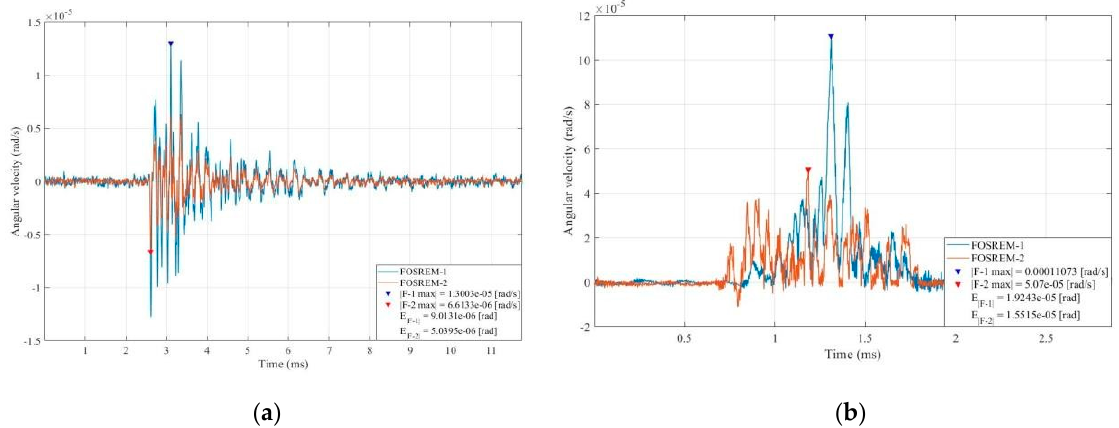
Figure 3. Data recorded by the FOSREMs in the geophysical observatory in Ksi ąż , Poland: ( a ) torsion event on the 1 December 2017, at 12:19 UTC, ( b ) tilt event on the 13 December 2017, at 11:15